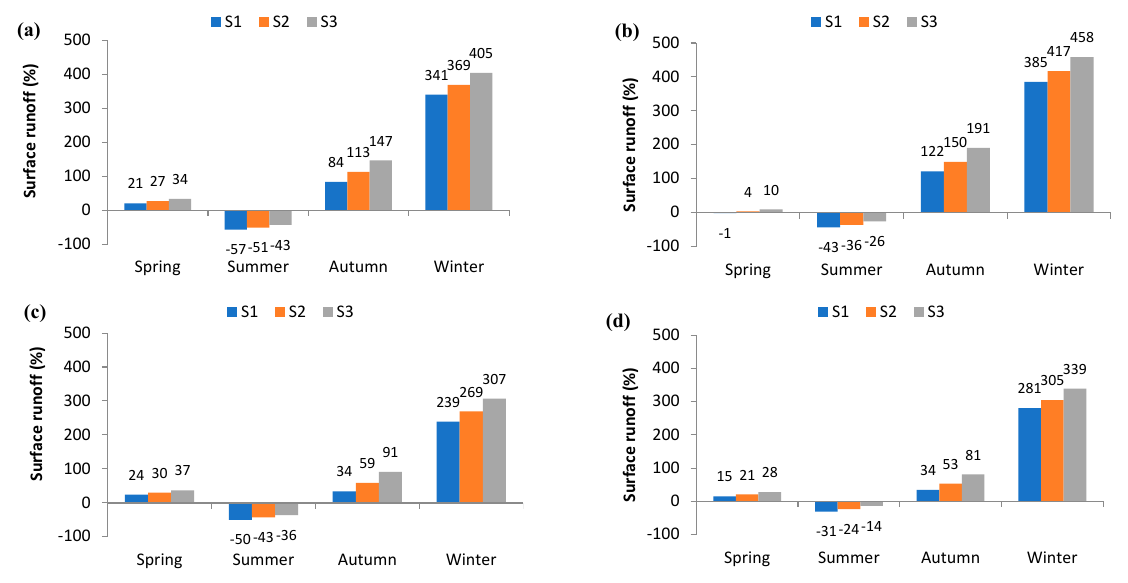
Figure 9. Seasonal surface runoff (%) projected for 2040–2069 in: ( a ) REMO4.5, ( b ) CLM4.5, ( c ) REMO8.5, and ( d ) CLM8.5.